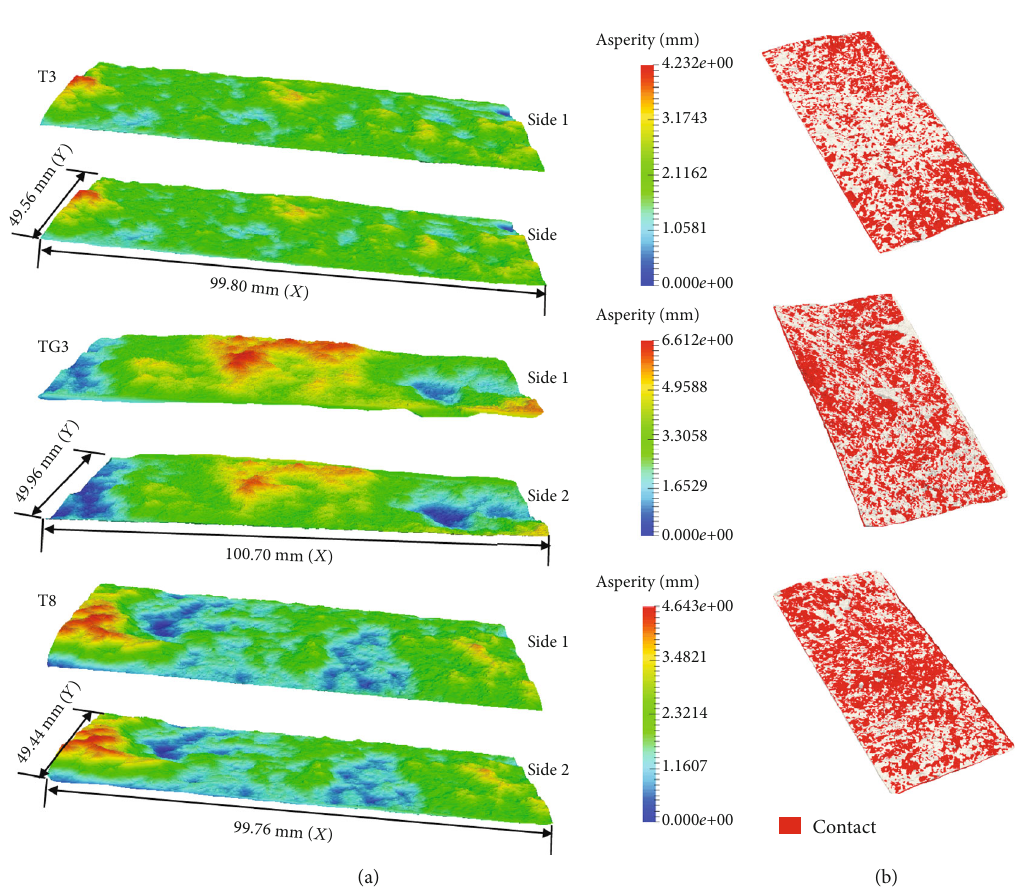
Figure 2: (a) 3D surface topography for both sides and (b) contact state of di ff erent